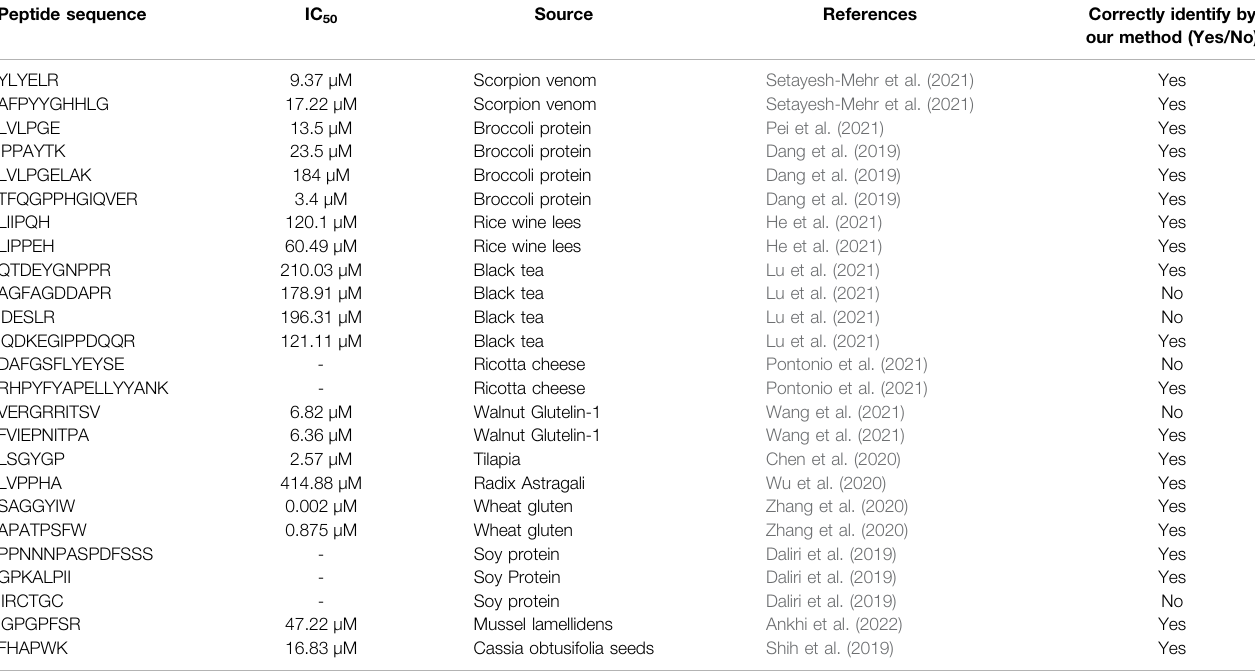
TABLE 5 | Performance evaluation of the proposed method using recently reported novel AHTPs. Peptide